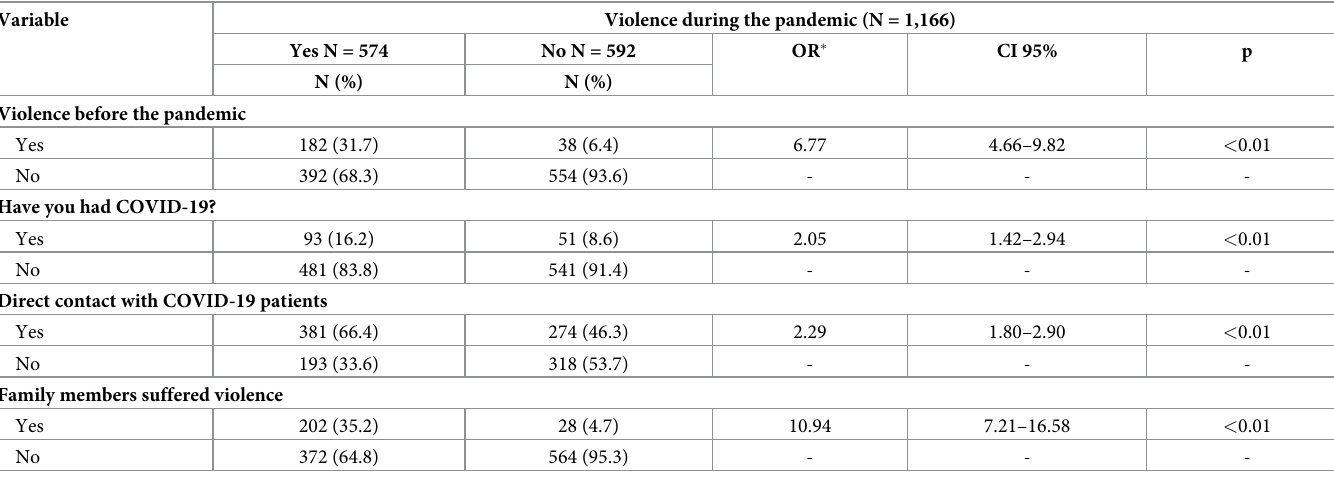
Table 4. Professional variables and risk of suffering violence in the pandemic. Variable